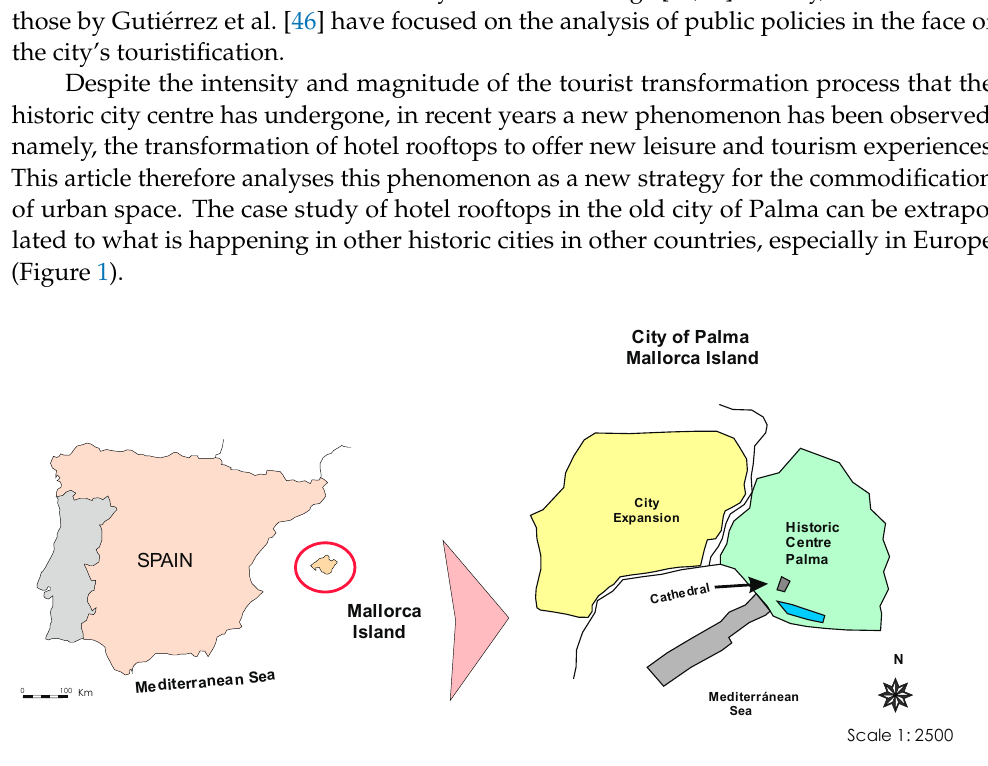
Figure 1. Localization of Palma City and the Historic Centre. Source: Authors.